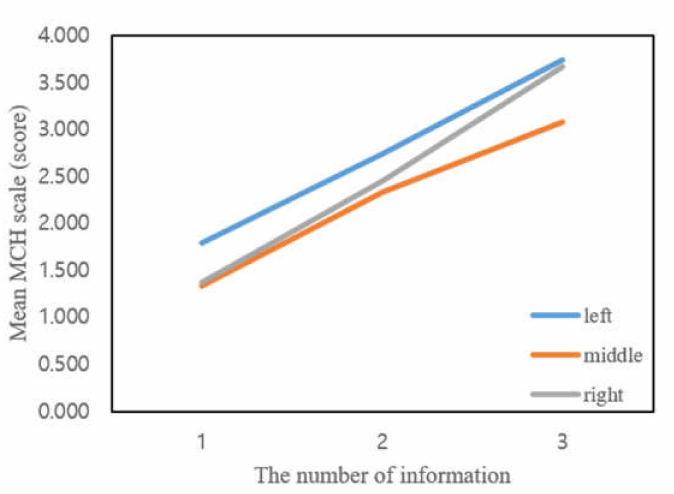
Figure 9. Modified Cooper–Harper handling (MCH) scale according to the level of the number of information and area of HUD.